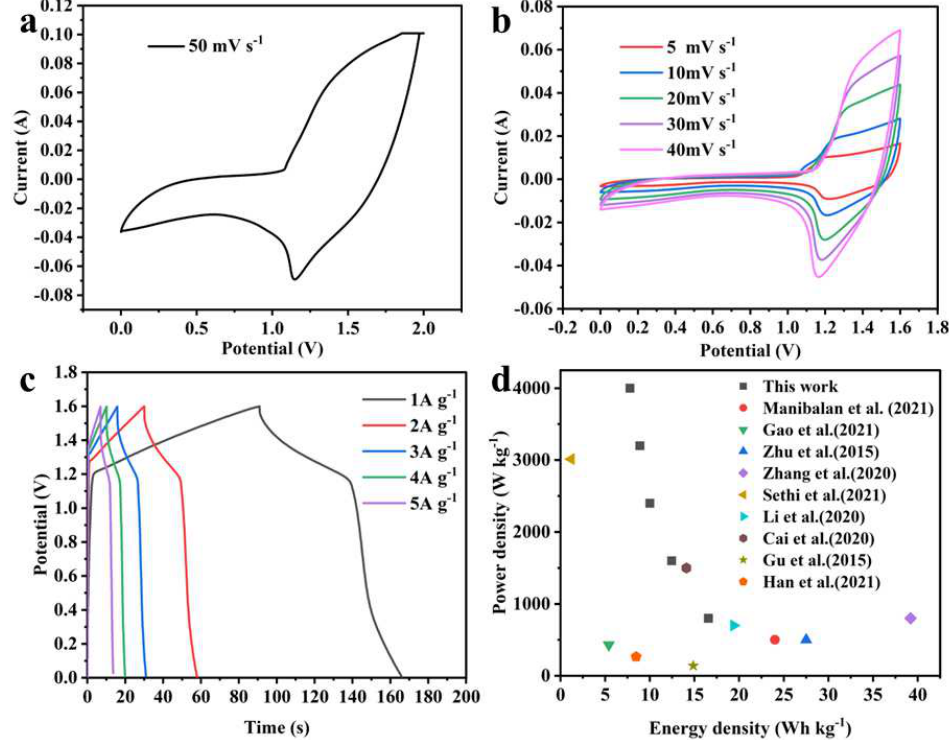
Figure 8. ( a ) CV curve of CNFs@ Ni(OH) 2 /NiO-250//AC ASC at 0–2 V at 50 mV s − 1 . ( b ) CV curves of ASC at diverse scan rates. ( c ) GCD curves of ASC at diverse current densities. ( d ) Ragone diagram